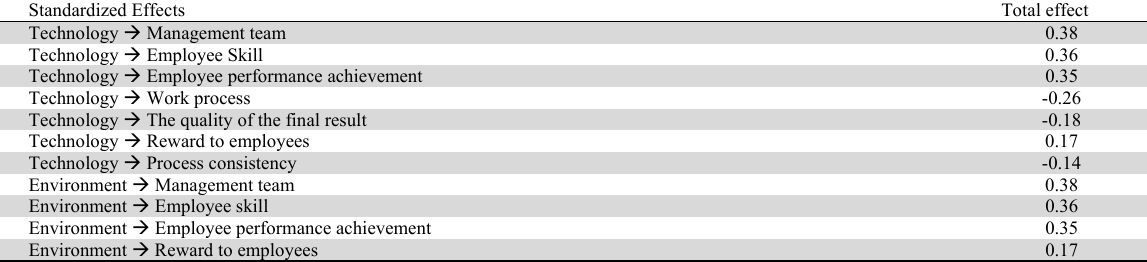
Standardized effects of exogenous latent variables on their indicators